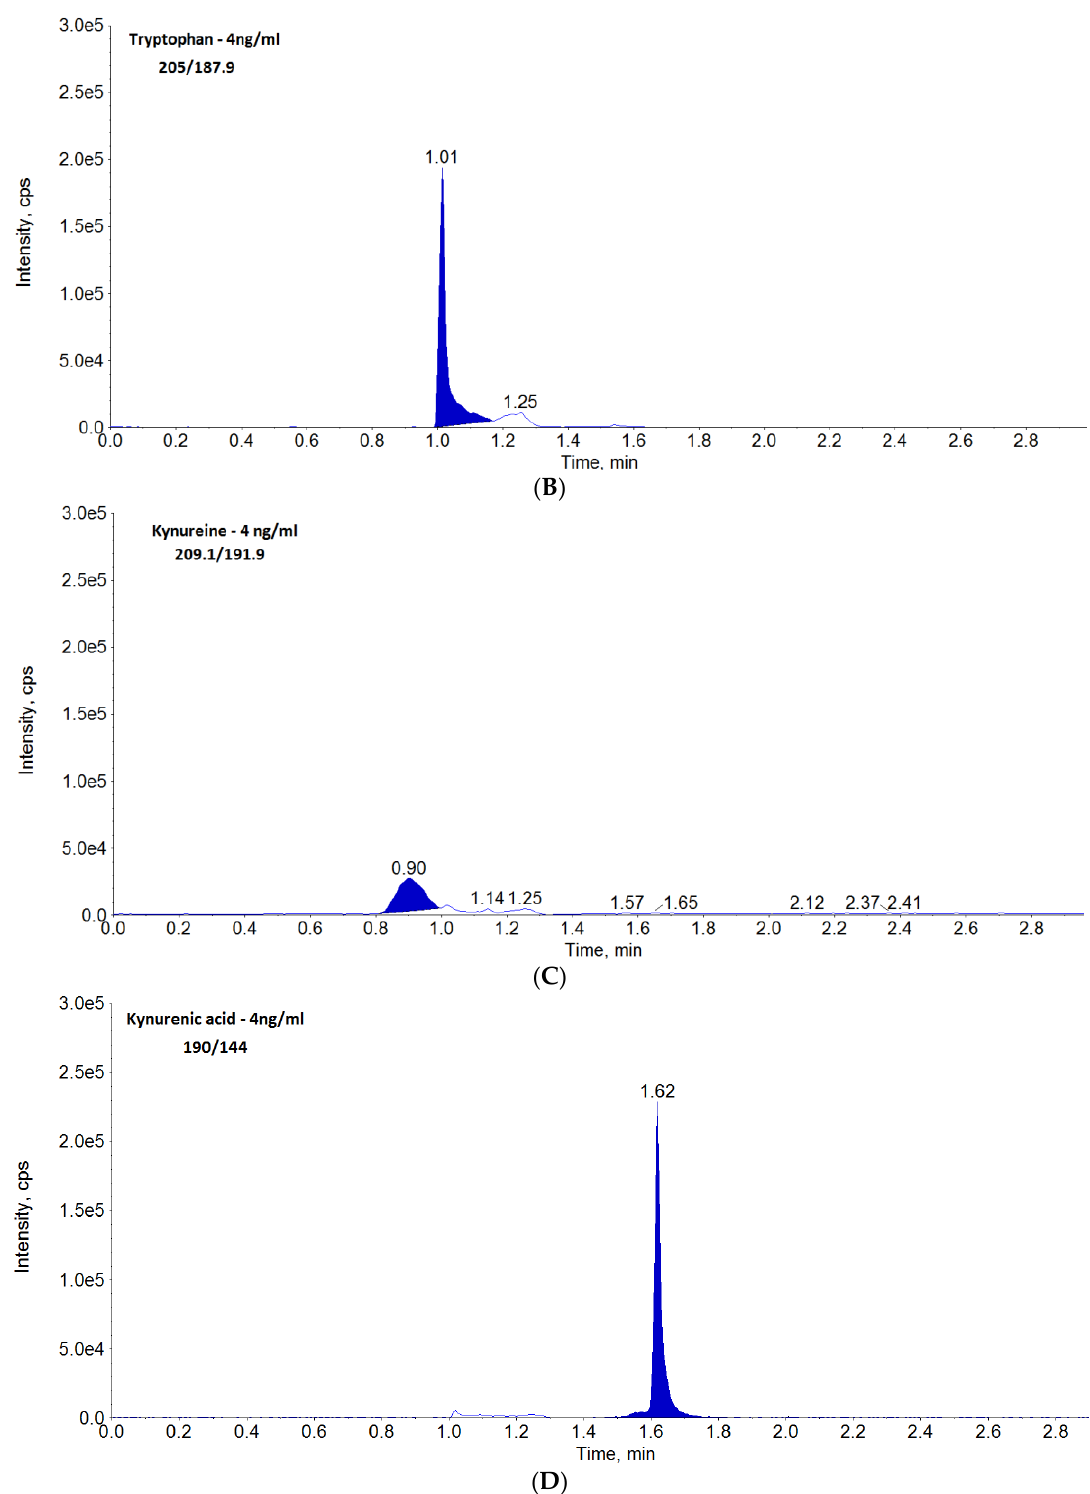
Figure 1. Chromatograms obtained from analysis of standards of IS ( A ), tryptophan ( B ), kynurenine ( C ), kynurenic acid ( D ) by LC-MS/MS.